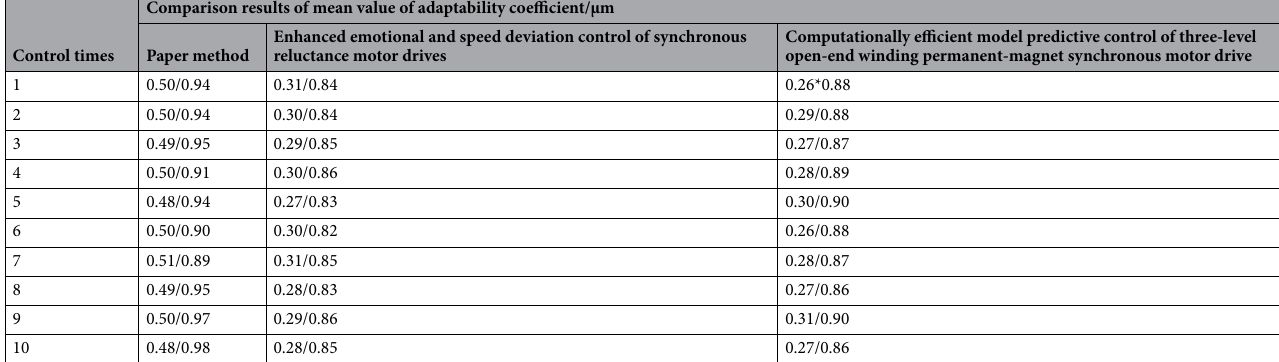
Table 2. Comparison results of average value of adaptability